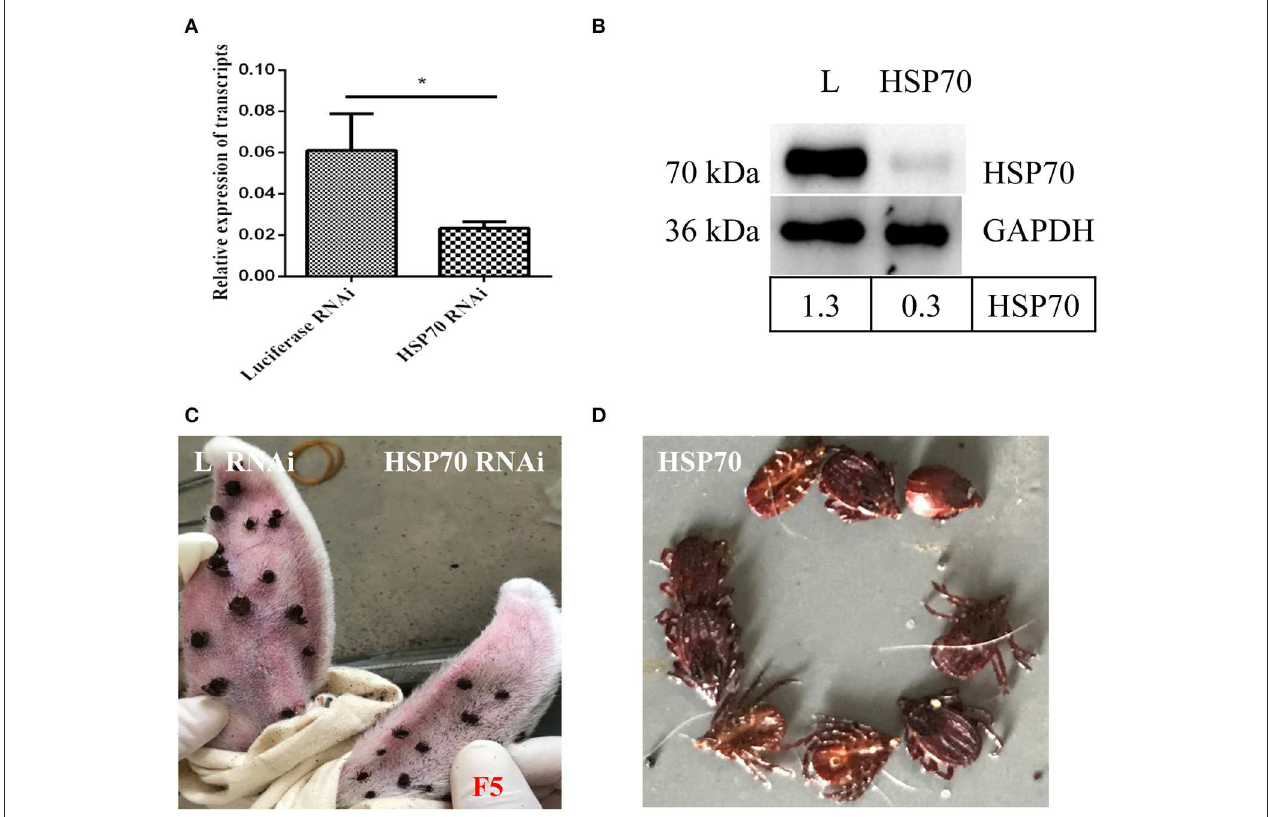
FIGURE 8 | Effect of HSP70 gene knockdown on tick blood feeding. Relative expression level of HSP70 was determined by real-time quantitative PCR (A) and Western blot (B) after interference with HSP70 dsRNA vs. luciferase dsRNA. The data were normalized to tick elongation factor 1 α and gene-specific standard was the HSP70 plasmid. * means statistical significance that p -values less than 0.05. Tick attachment was observed at 5 days blood feeding (C,D) . It shows HSP70 gene-knocked down inhibits blood feeding and increases tick death. F5, 5-day-fed ticks; L, luciferase RNAi groups.